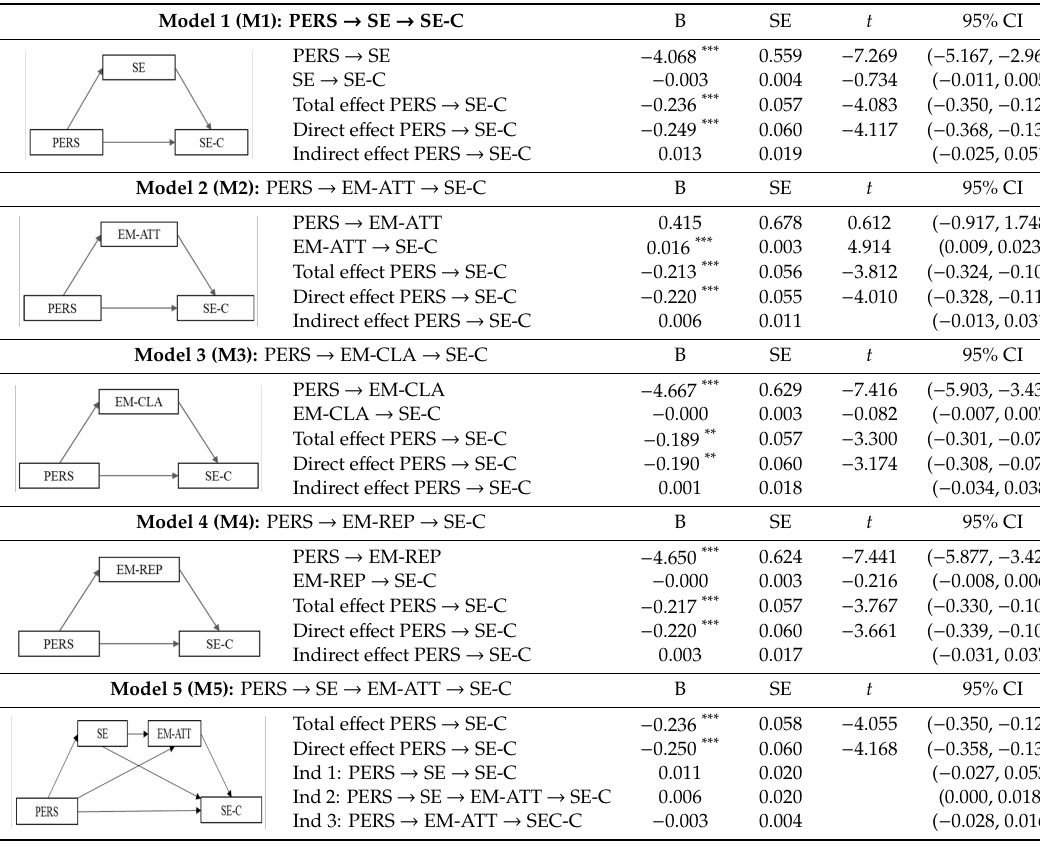
Table2. Mediationmodelsforself-esteemandtheEIcomponentsintherelationshipbetweenpersonality and self-expressive